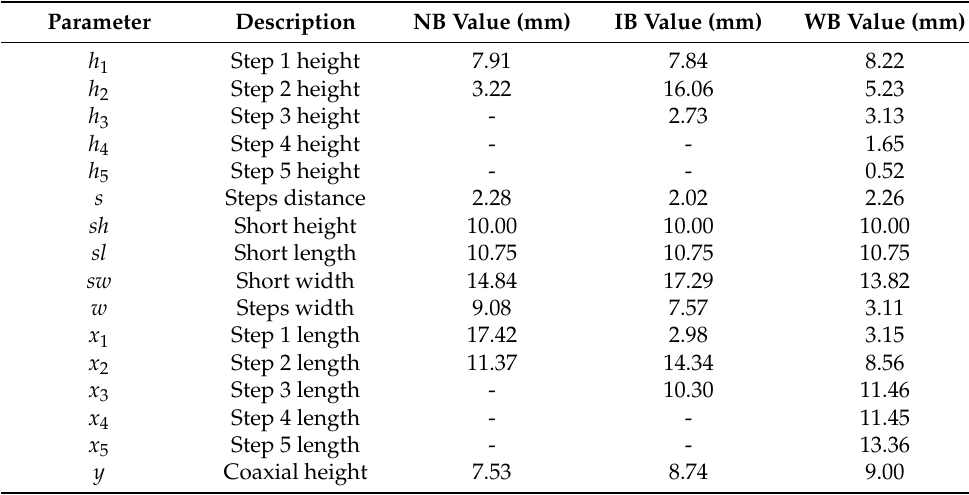
Table 2. Coaxial-to-GGW transitions geometrical